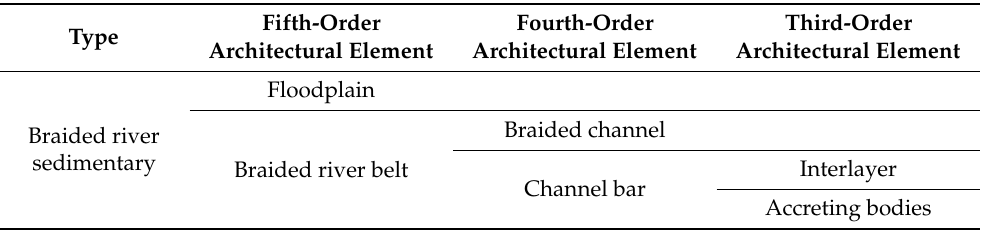
Table 1. Classification scheme for the H1 Section 5–3 architecture of the Daniudi gas